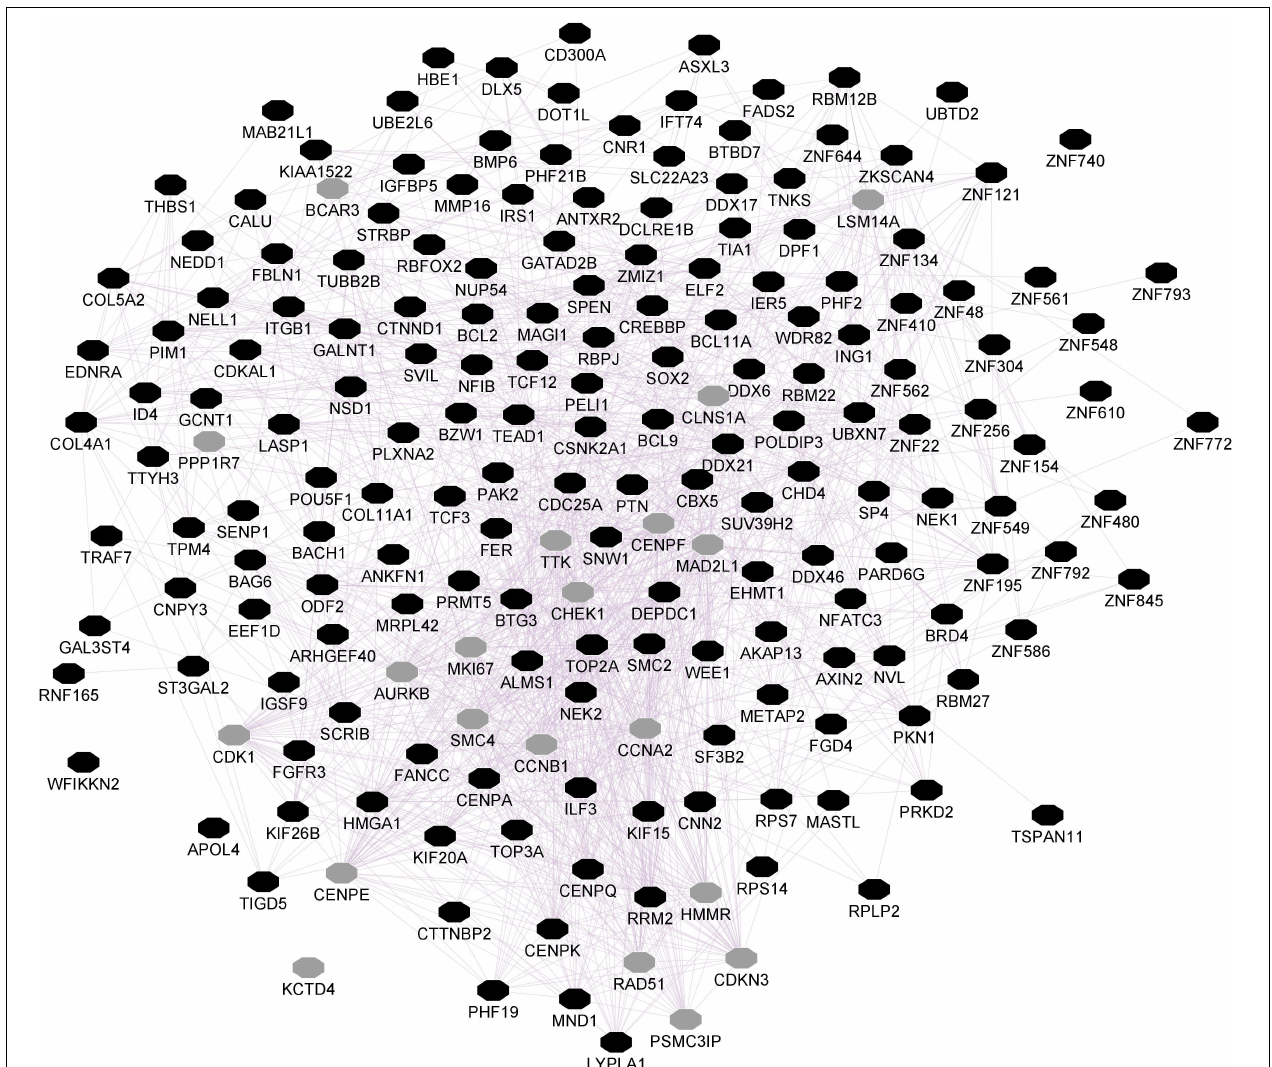
FIGURE 3 | Hippocampal CNR1 gene network using GeneMANIA. Black hexagons indicate query genes, whereas gray hexagons indicate related genes added by GeneMANIA. Node sizes represent gene scores, reflecting how often paths that start at a given gene node end up in one of the query